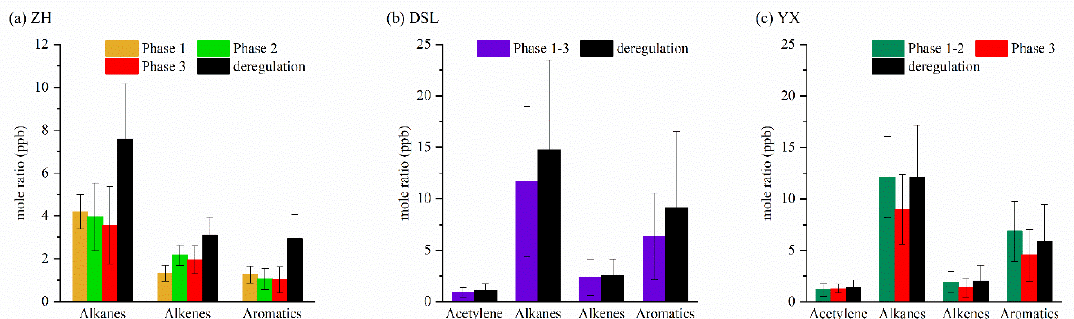
Figure 7. The average mole ratio of VOCs in different control periods at the ZH ( a ), DSL ( b ) and YX ( c ) sites during the G20 summit.